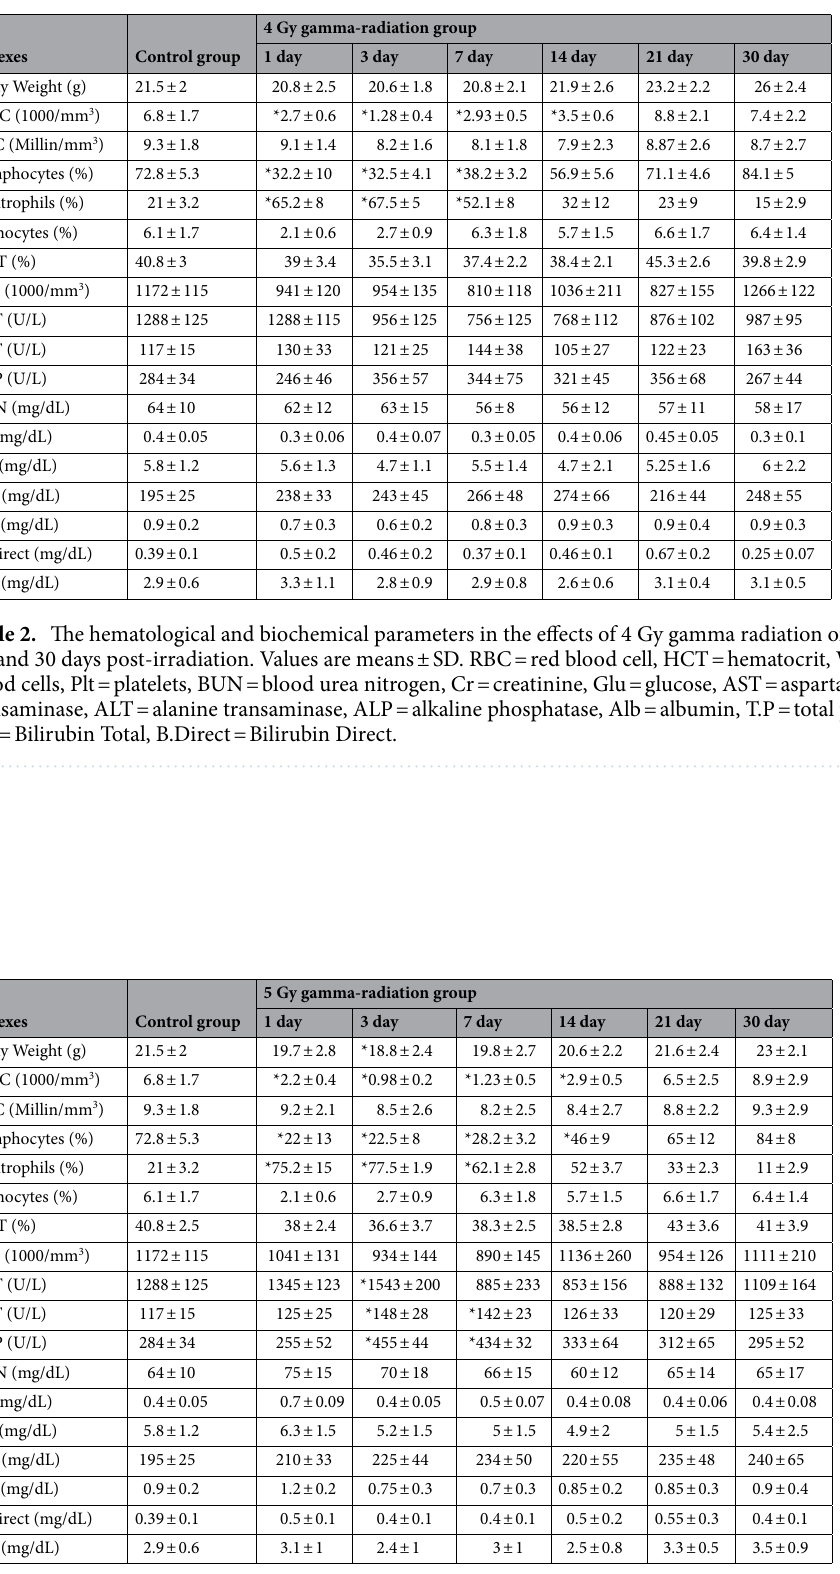
Table 3. The hematological and biochemical parameters in the effects of 5 Gy gamma radiation on 1, 3, 7, 14, 21, and 30 days post-irradiation. Values are means ± SD. *P < 0.05 compared to the control group. Values are means ± SD. RBC = red blood cell, HCT = hematocrit, WBC = white blood cells, Plt = platelets, BUN = blood urea nitrogen, Cr = creatinine, Glu = glucose, AST = aspartate transaminase, ALT = alanine transaminase, ALP = alkaline phosphatase, Alb = albumin, T.P = total protein, B.T = Bilirubin Total, B.Direct = Bilirubin